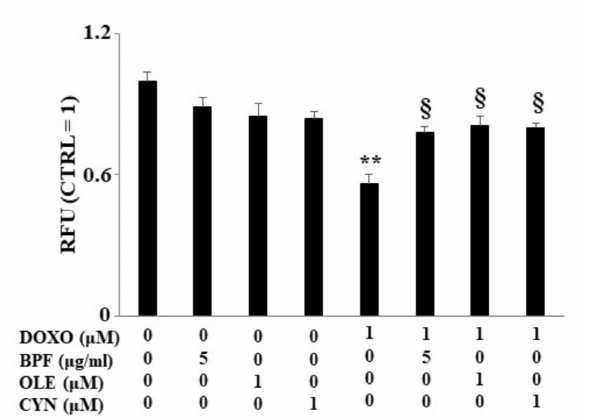
Figure 4. Lipid content measurement. The lipid content was analyzed spectrophotometrically after treatment with 1 µ M DOXO for 6 h; BPF (5 µ g/mL), OLE (1 µ M), or CYN (1 µ M) for 24 h; or co-treatments. Values of three independent experiments are expressed as the means ± standard deviations. ** denotes p < 0.01 vs. control; § denotes p < 0.05 vs. DOXO. The Analysis of Variance (ANOVA) was followed by the Tukey–Kramer comparison